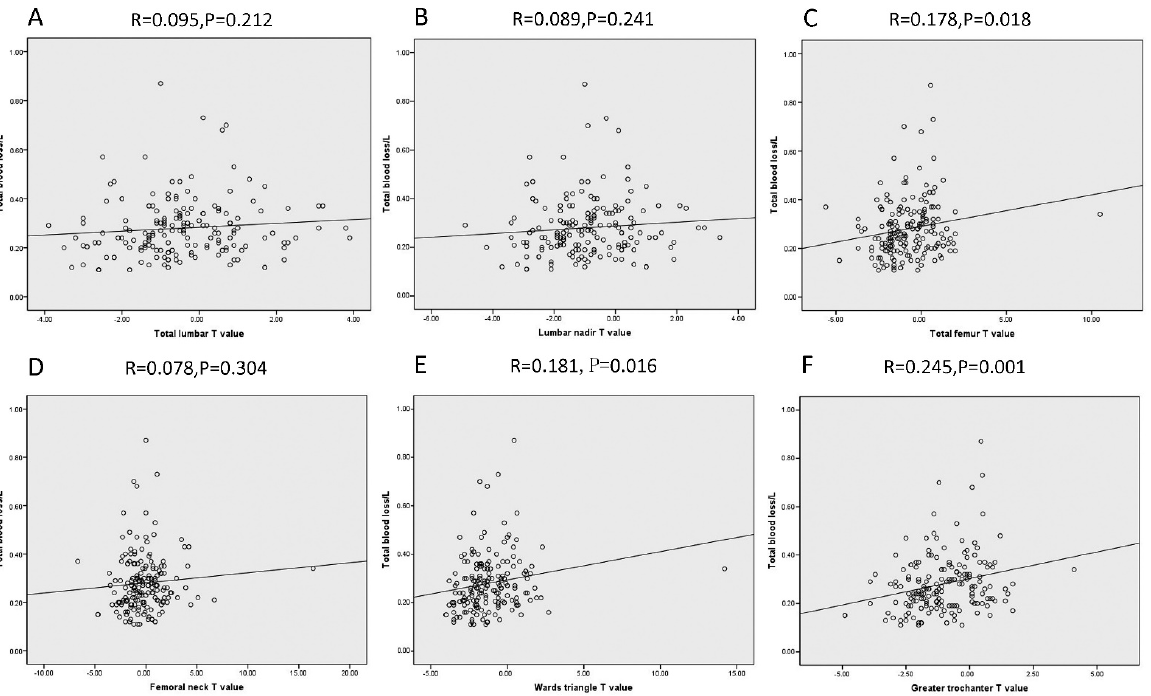
Figure 3. ( A – C ): Association between total blood loss volume and total lumbar T value, lumbar nadir T value, and total femoral T value. ( D – F ): Association between total blood loss volume and femoral neck T value, Ward’s triangle T value, and femoral greater trochanter T